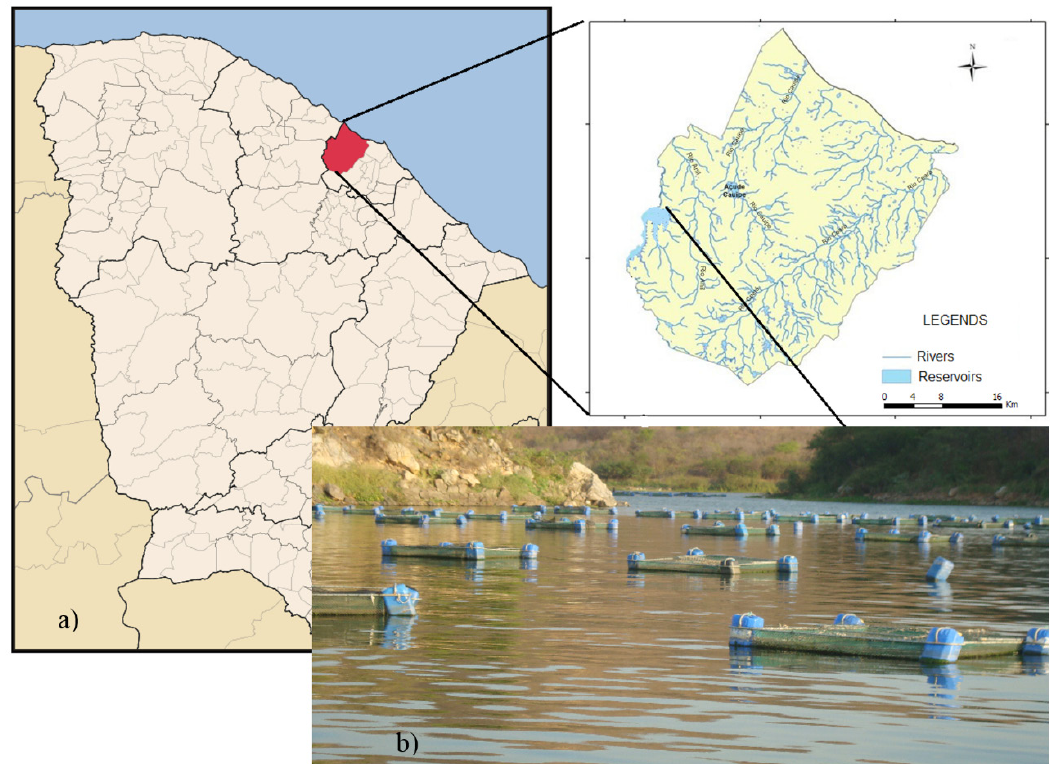
Figure 1. a) Geographic location of Sítios Novos reservoir in Caucaia, Ceará, Brazil; b) fish farming in Sítios Novos